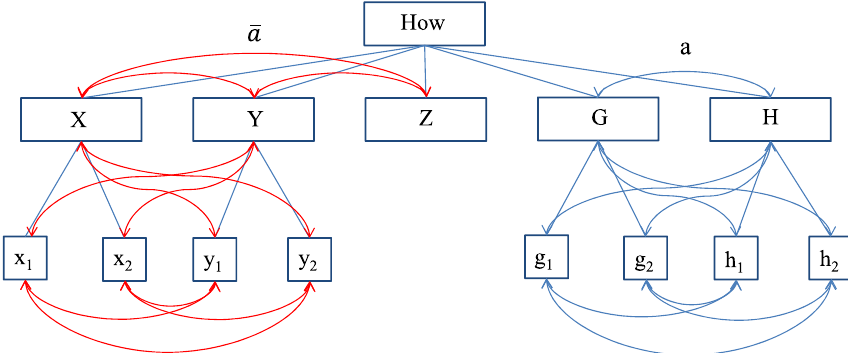
Fig. 4 The relation properties between elements in “How class” of 4W1H ontology with R(x,y) action x does not affect action y and R(x,y) [17]